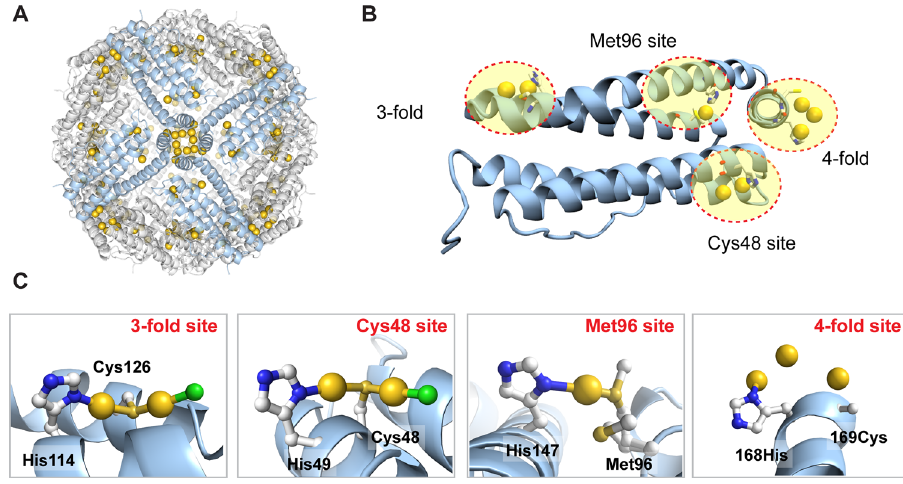
Fig. 2 X-ray crystal structure of Au(400 equiv.)-apo-R168H/L169C-rHLFr containing the highest number of bounded Au. A The whole spherical cage structure of Au(400 equiv.)-apo-R168H/L169C-rHLFr shows the immobilization of Au ions (yellow sphere) inside the cage. B Assigned Au binding sites on the monomer of Au(400 equiv.)-apo-R168H/L169C-rHLFr. C Coordination structures of the bounded Au in each site as shown in B . Figures were made in